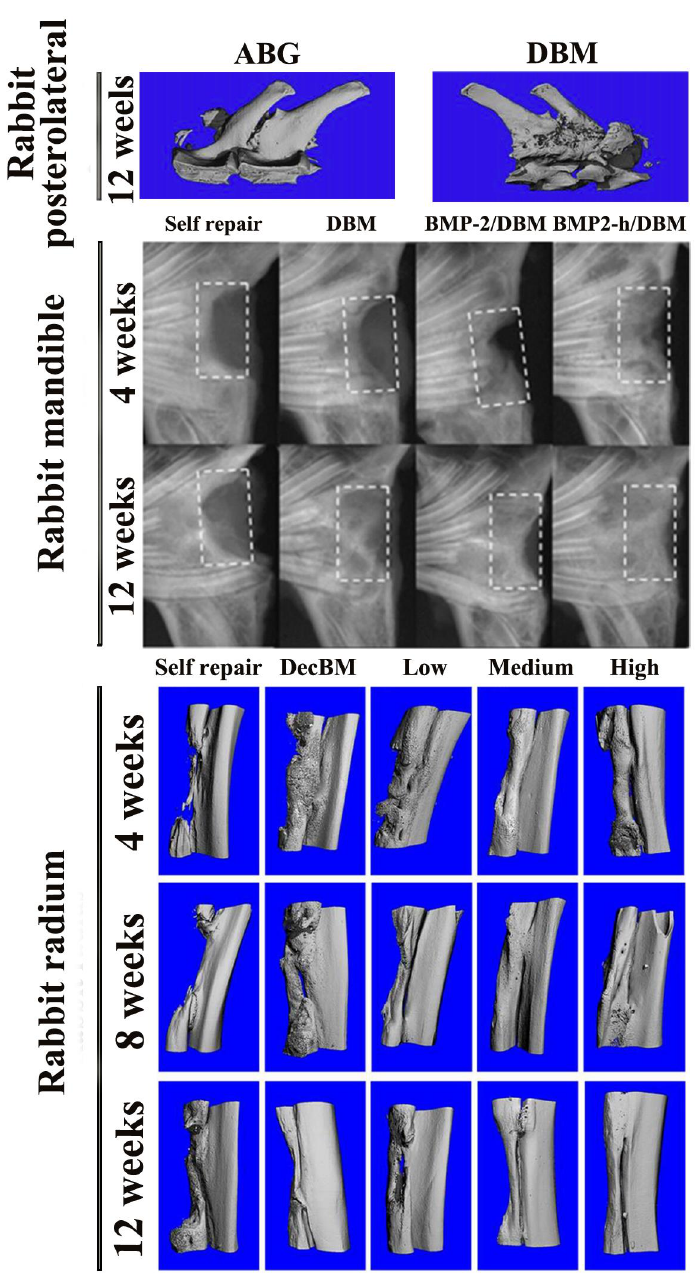
Figure 3. Repair and reconstruction of different natural bone grafts implanted in different sites in rabbit bone defect model. DecBM, decellularized bone matrix. Self repair, defect repair without any scaffold. Low, low stiffness decellularized bone composite scaffold. Medium, medium stiffness decellularized bone composite scaffold. High, high stiffness decellularized bone composite scaffold. DBM, demineralized bone matrix. BMP2-h, collagen-binding bone morphogenetic protein-2. ABG, autologous bone graft. Reproduced with permission [73]. Copyright John Wiley & Sons, 2016.